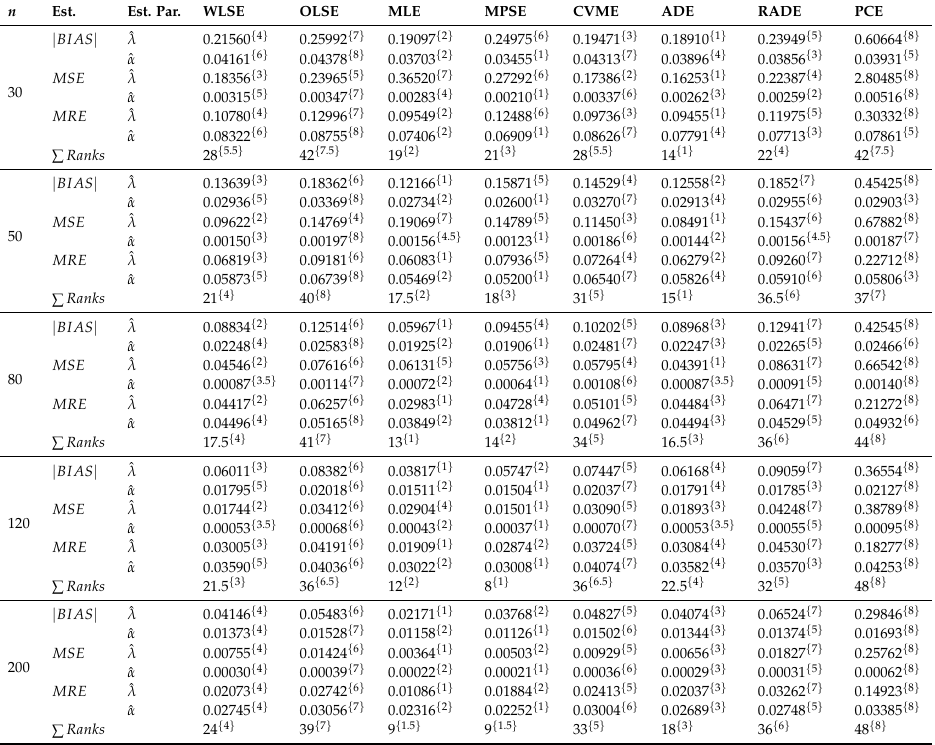
Table 2. Simulation results for φφφ = ( λ = 2.0, α = 0.5 ) (cid:124) .